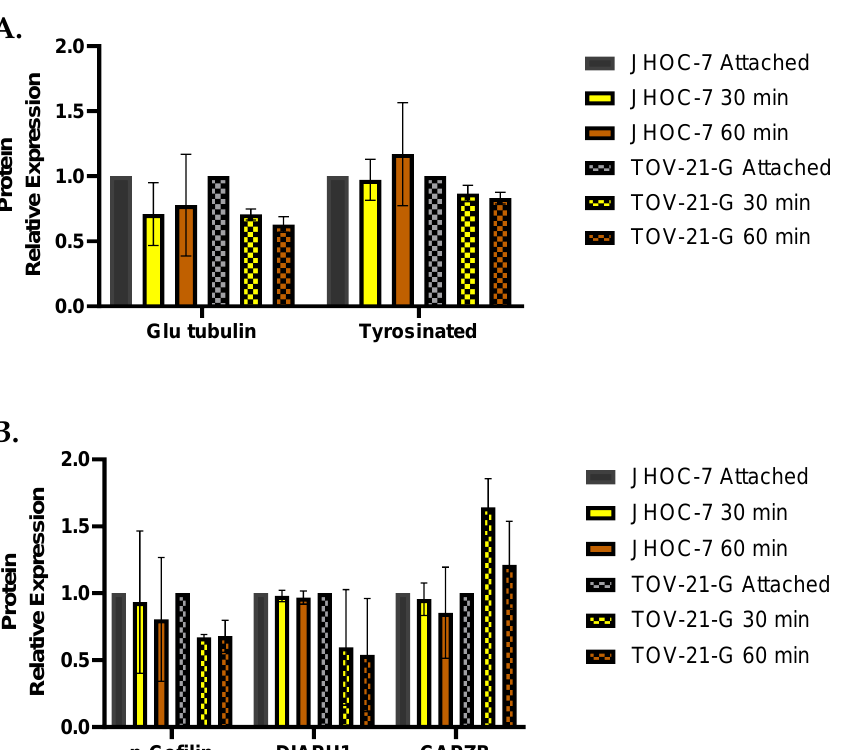
Figure 6. Expression of α -tubulin post-translational modifications ( a ) and actin regulatory proteins ( b ) in attached and detached cells. In the attached state, JHOC-7, the only cell line completely void of McTNs exhibited high levels of expression of tyrosinated tubulin and p-cofilin relative to McTN-forming TOV21G. Tubulin regulatory proteins were normalized to α -tubulin. Actin regulatory proteins were normalized to cofilin ( n = 3). Mean and standard error of the mean are shown. No significant differences were found with one-way ANOVA analysis.